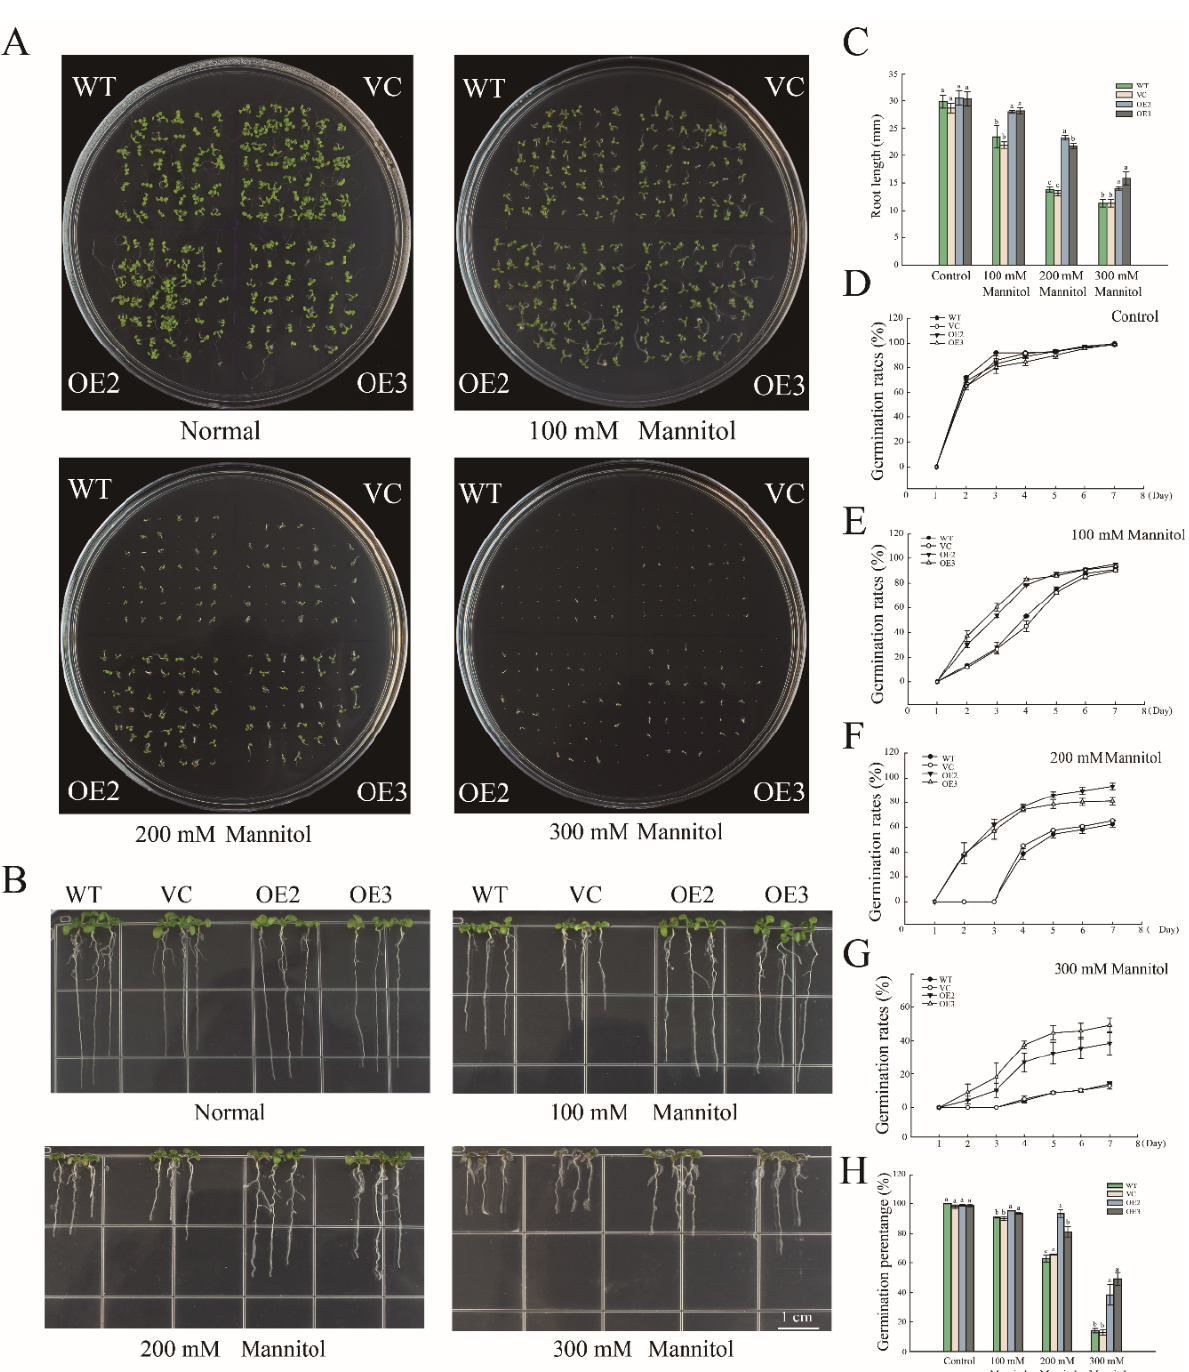
Figure 2. PwNAC11 overexpression promotes seed germination under simulated drought conditions. ( A ) Germination assay under different concentrations of mannitol treatments. ( B ) Root elongation assays under different concentrations of mannitol treatments. ( C ) Quantification of root length under different concentrations of mannitol treatments. Different letters indicate significant differences at p -value < 0.05. ( D – G ) Germination rates of different lines under different concentrations of mannitol treatments within 7 days. ( H ) Germination percentage of each line after 7-day simulated drought treatment. Different letters indicate significant differences at p -value < 0.05.